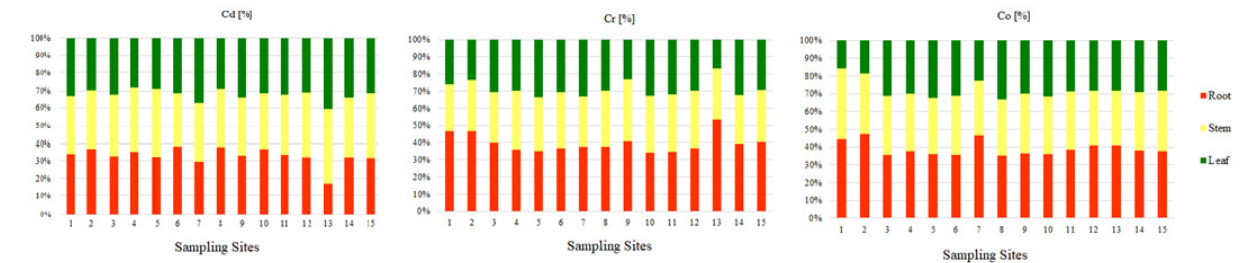
Figure 5. Percentage of trace elements (Cd, Cr, Co) in individual parts of aquatic plants (root, stem, leaf) collected in the Pisa River and its tributaries.